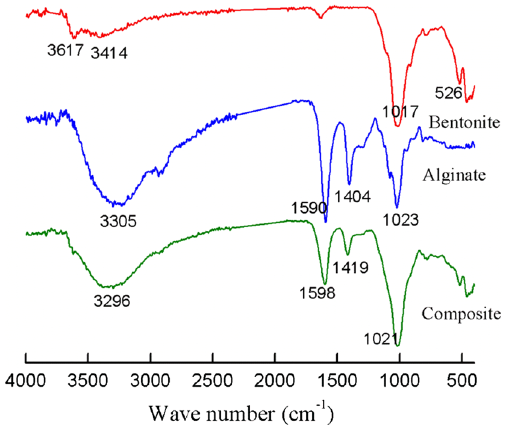
Fig. 3 FTIR spectra of bentonite